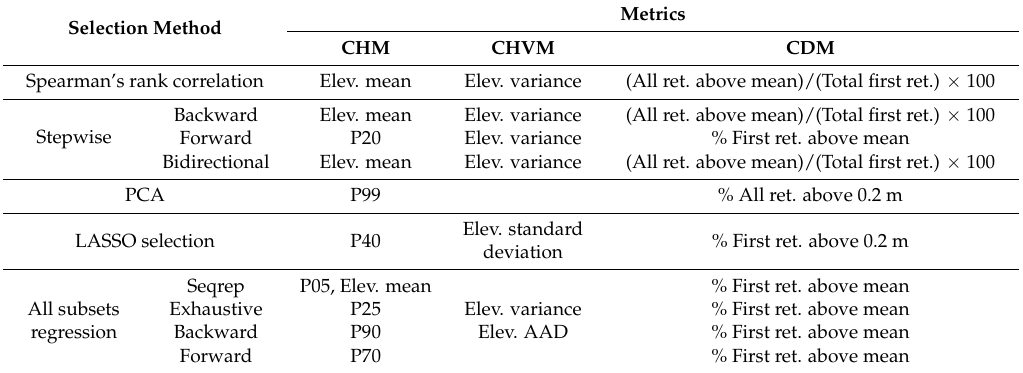
Table 3. ALS selected metrics using different variable selection methods, when applying a threshold value of 0.2 m to the point cloud data. Seqrep is sequential replacement; P refers to the percentile e.g., P05 is the 5th percentile; Elev. is Elevation; ret. is returns; Elev. AAD is average absolute deviation.